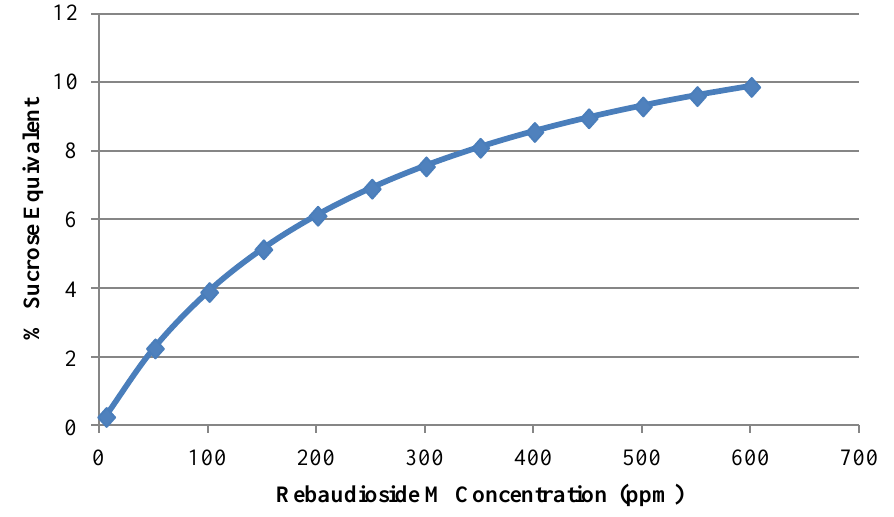
Figure 4. Concentration-response curves of rebaudioside M ( 7 ) in water at 4